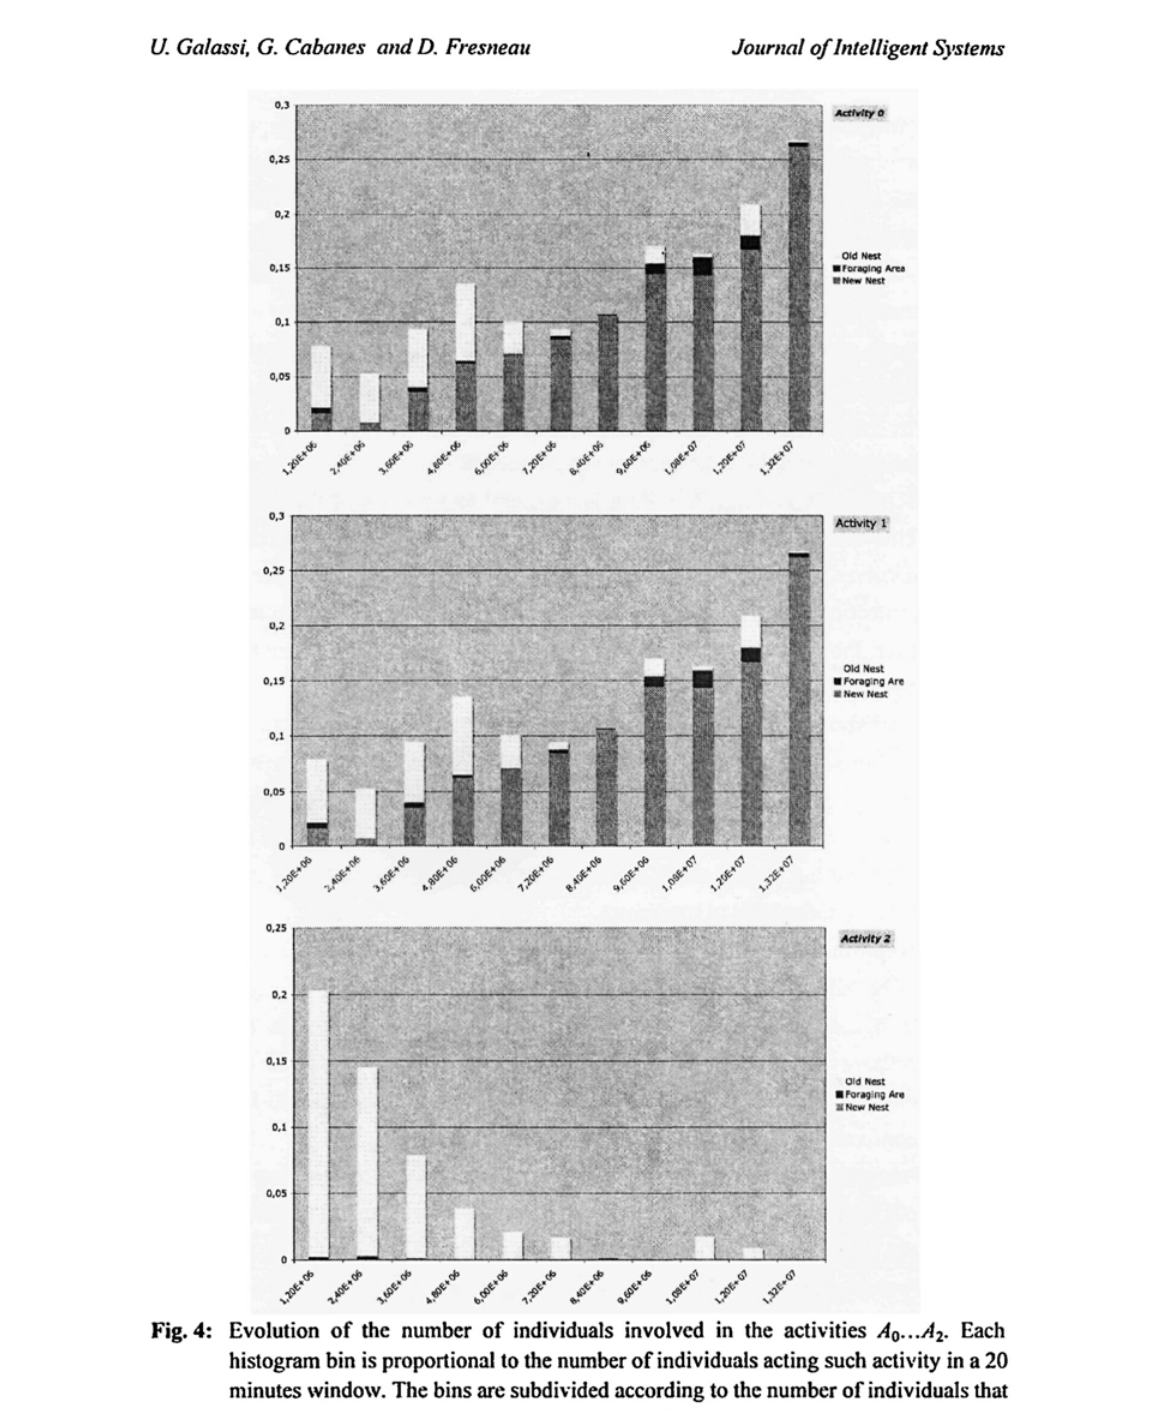
Fig. 4: Evolution of the number of individuals involved in the activities A 0 .. .A 2 . Each histogram bin is proportional to the number of individuals acting such activity in a 20 minutes window. The bins are subdivided according to the number of individuals that arc present in the old nest, the foraging area or the new